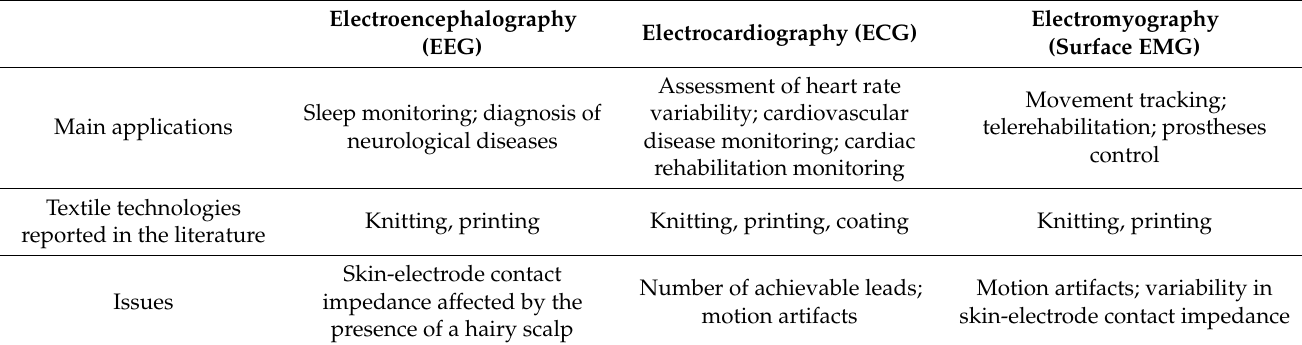
Table 3. Synthesis of the main characteristics of biopotentials and used electrodes.